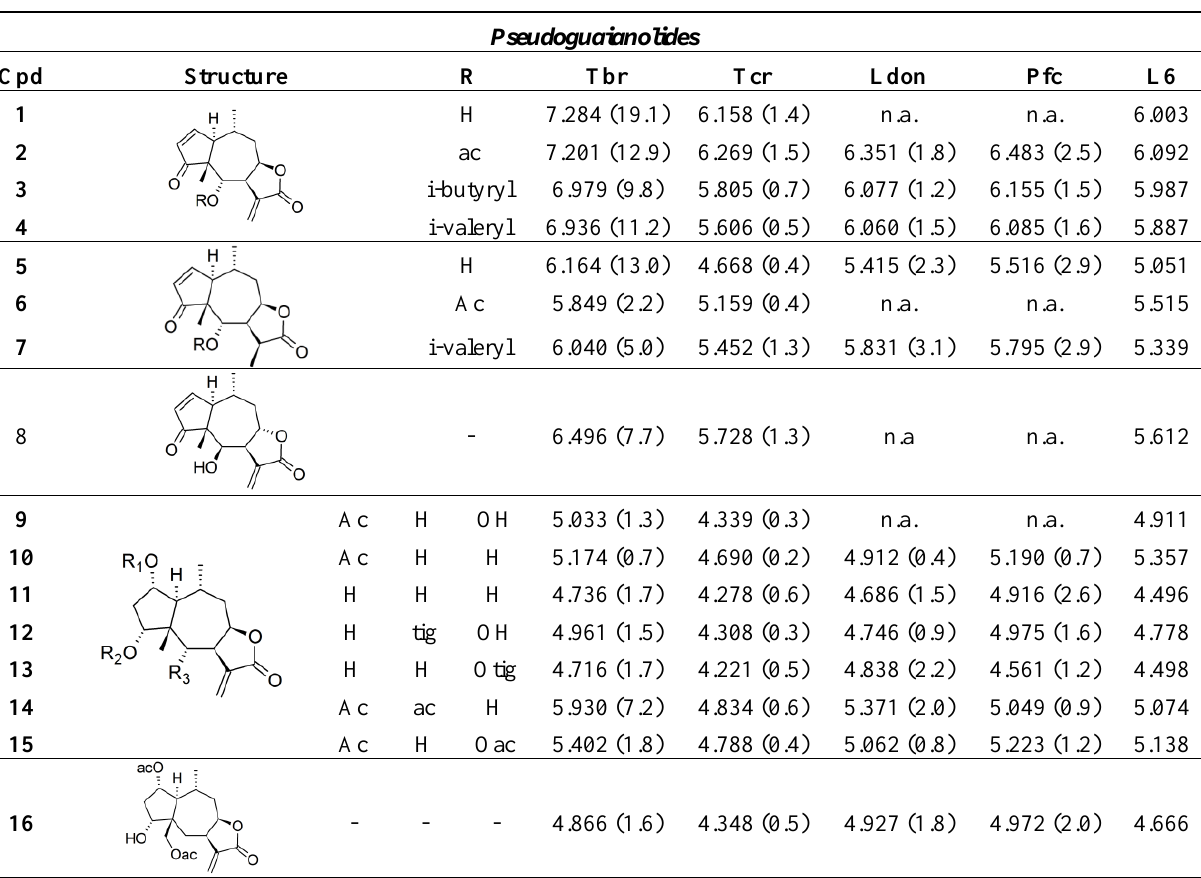
(L6)/IC (parasite) and showed between 50 50